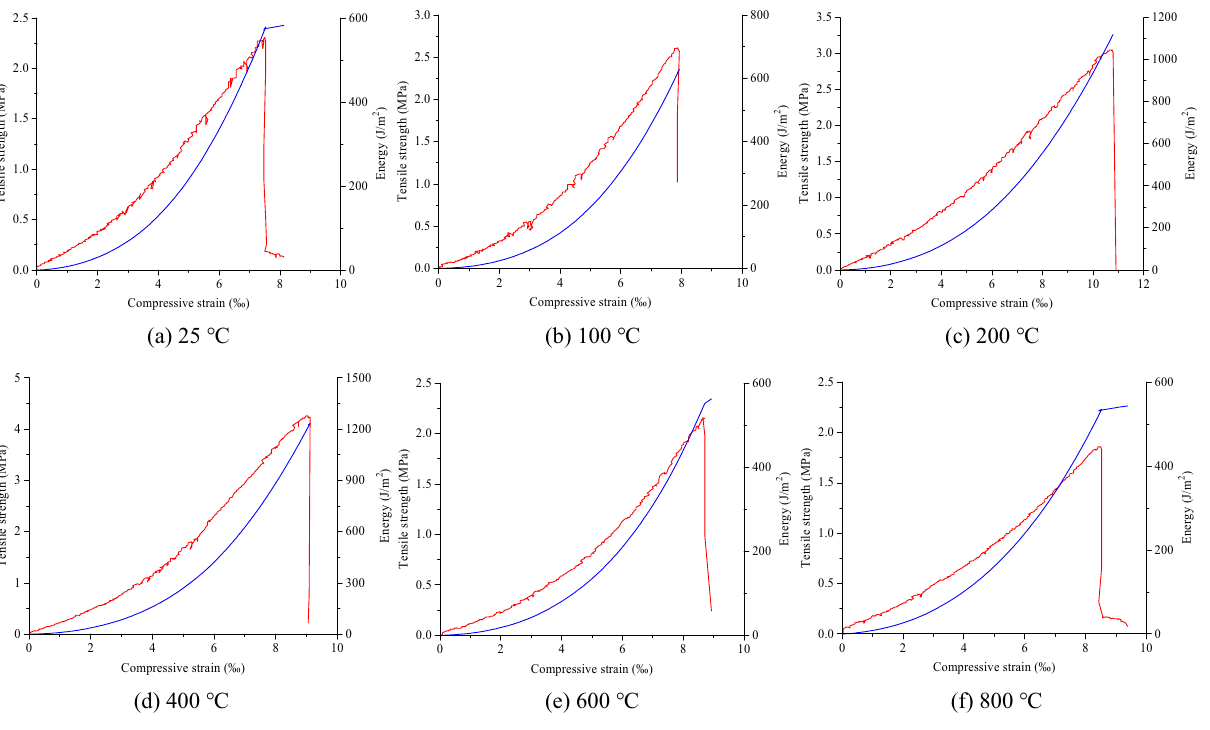
Figure 11. Tensile strength–temperature–energy relationship of the #1 coarse sandstone samples treated at different temperatures.